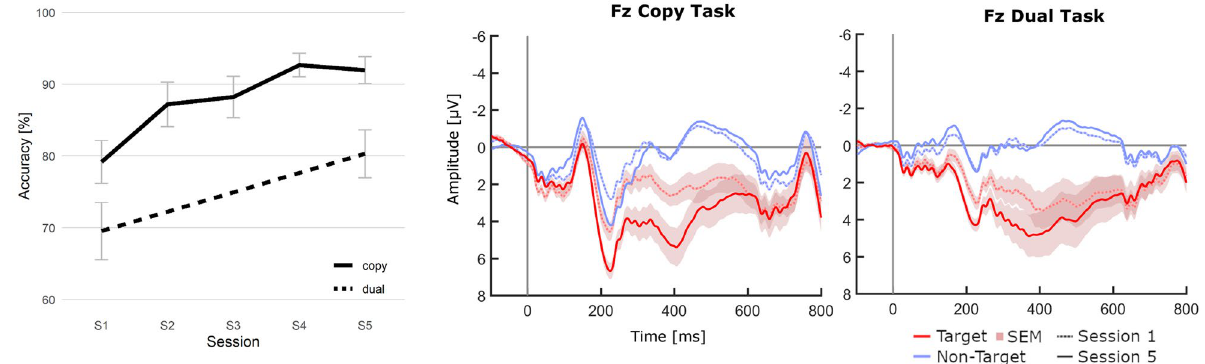
Figure 4. Development of BCI accuracy and comparison of copy and dual task conditions across sessions. Left: Average BCI accuracies achieved during the respective tasks. Shaded areas and error bars indicate SEM. Right: Target vs. non-target epochs at Fz from copy and dual tasks.